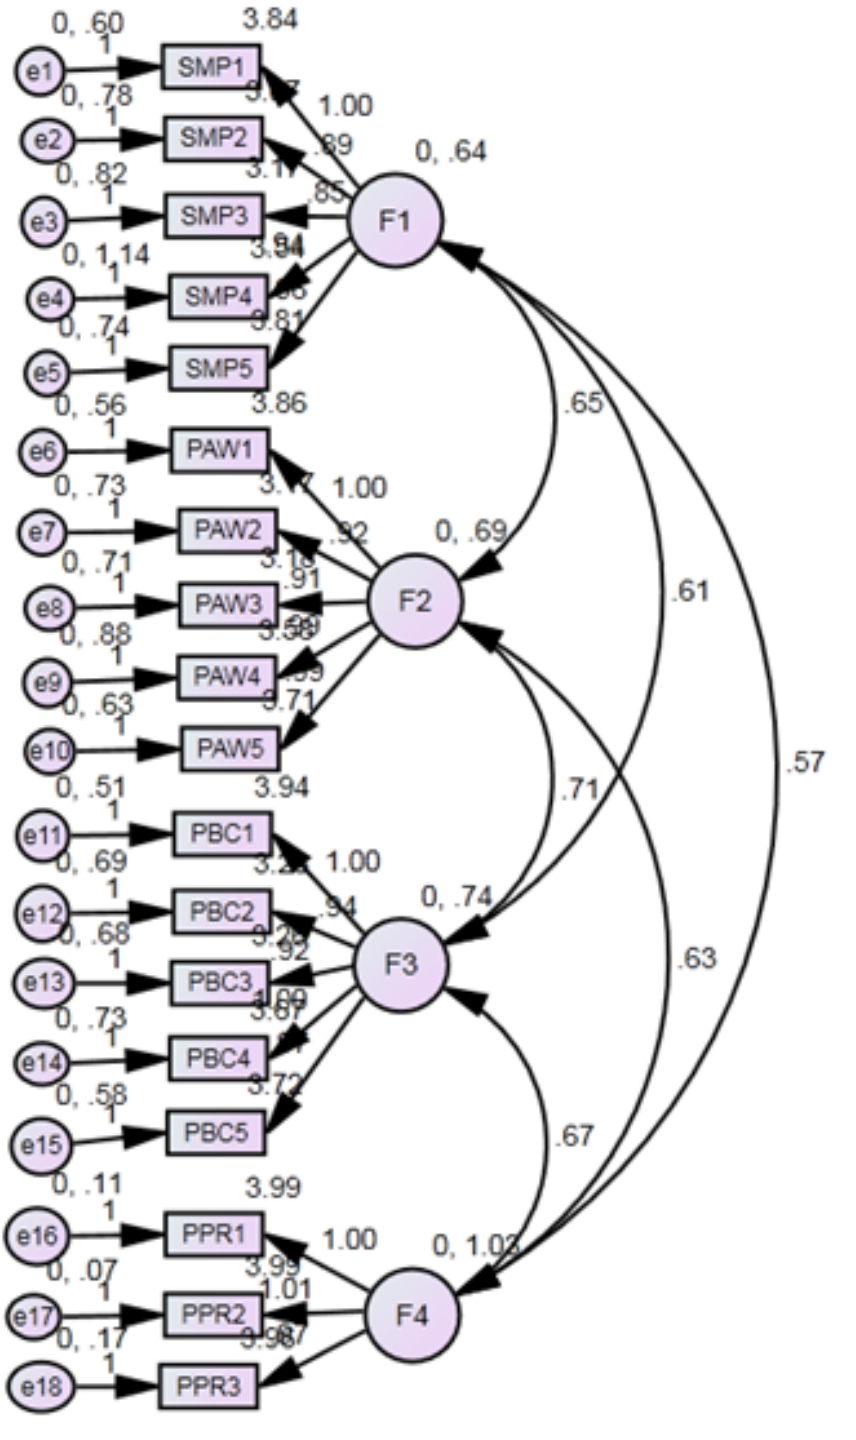
Figure 2. Measurement model showing the correlations among the four research